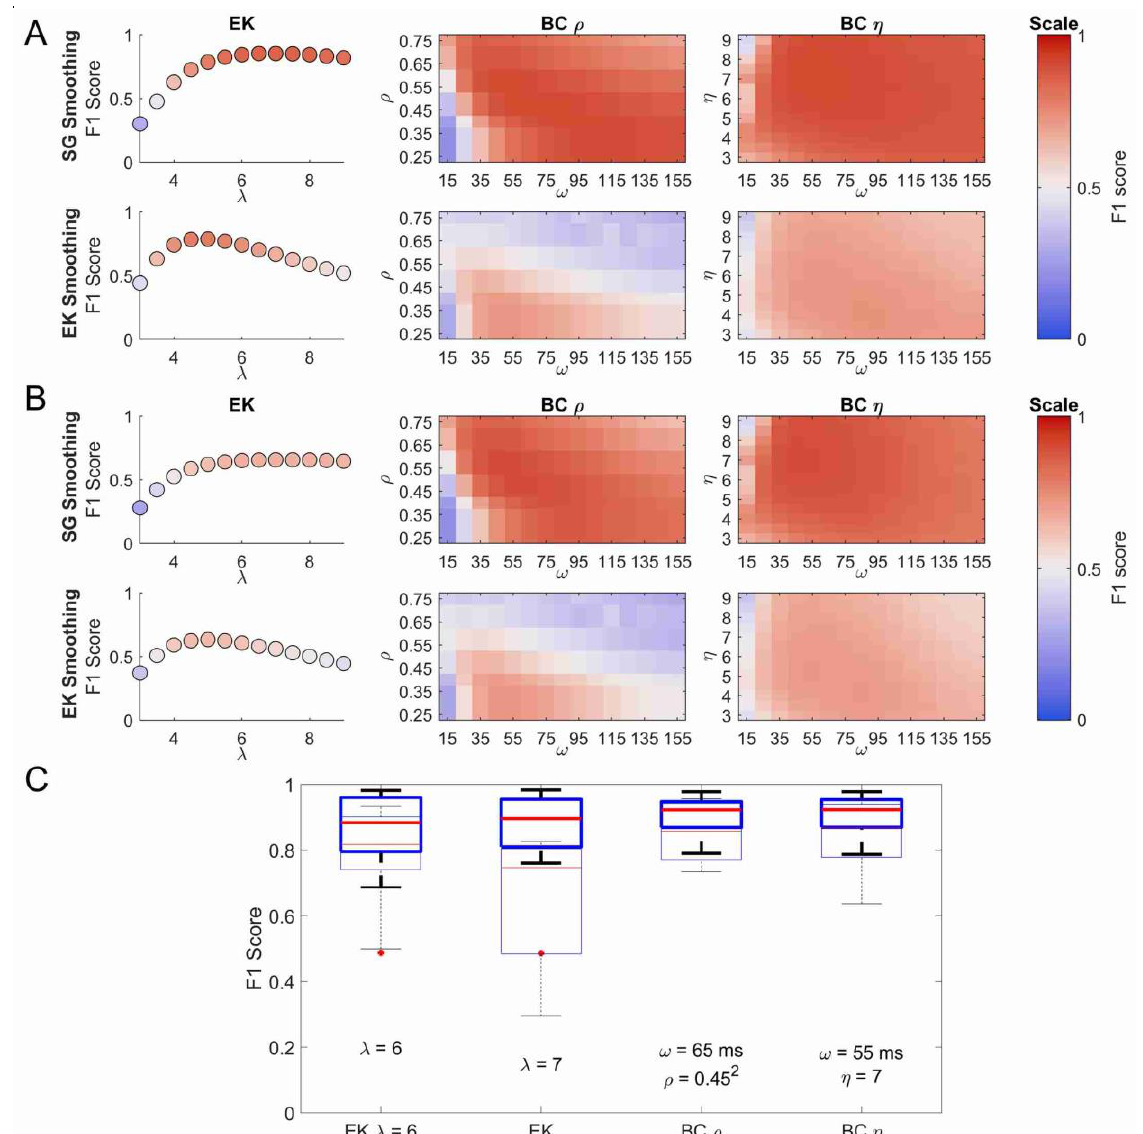
Figure 5: Comparison of the EK and the BC methods using the F1 score. Panels A and B show the F1 scores as a function of different parameter combinations for the three methods (EK:λ; BCη: ω and η; BCρ: ω and ρ), for this data smoothed using the Savitzky-Golay filter are shown above and data smoothed using the EK method are shown below. The colour map cho- sen is a perceptual colour map distributed by Kovesi (2015) under the name CET-D1. Panel A shows the F1 scores, ignoring MEs and SEs, while panel B shows the F1 scores when MEs are counted as FNs and SEs as FPs. The box plots in panel C show the spread of F1 scores for the 9 participants for Savitzky-Golay smoothing (5 from the Oxford dataset and 4 from the Lund dataset). For box plots the edges of the box represent the 25th and 75th percentiles, the line in the centre represents the median, while the errorbars show the most extreme values not considered outliers. Outliers are plotted as separate red plus symbols. The thinly-lined box plots represent the same parameter combinations but compared to a ground truth including both binocular and monocular microsaccades. Below the box plots the parameters used are given. They represent the opti- mal parameters across all participants, apart from the EK λ = 6, which is given for context, as λ = 6 is often a suggested starting